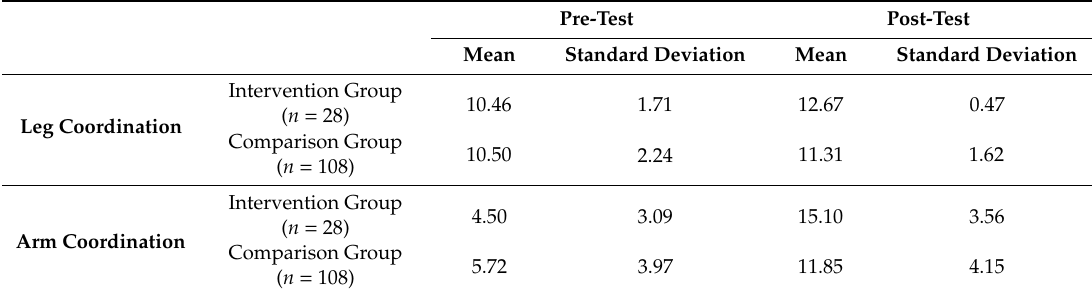
Table 2. General descriptive data on leg and arm